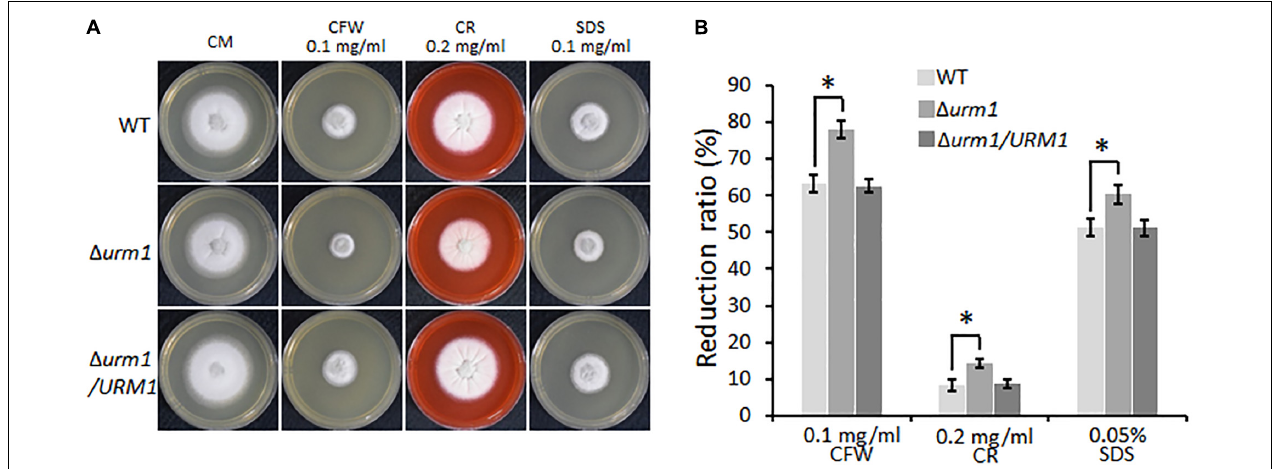
FIGURE 5 | Deletion mutants of URM1 are sensitive to cell wall disturbing agents. (A) Colony morphology of the wild type, (cid:49) urm1 mutant and complemented strains on CM plates supplemented with different cell wall disturbing agents. The colonies were photographed at 5 dpi. (B) Statistical analysis of growth reduction rates of colony growth under cell wall disturbing agents. Means and standard errors were calculated from three independent replicates. Significant differences were indicated by asterisks ( P < 0.05).